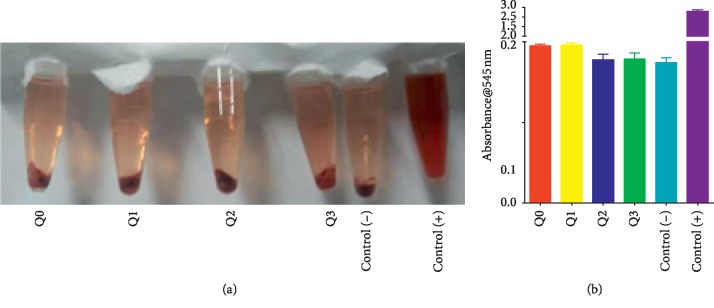
Composite hemolysis test. (a) None of the four materials caused hemolysis. (b) Supernatant of the area that underwent absorbance testing. Each value is the mean ± standard deviation of three determinations.